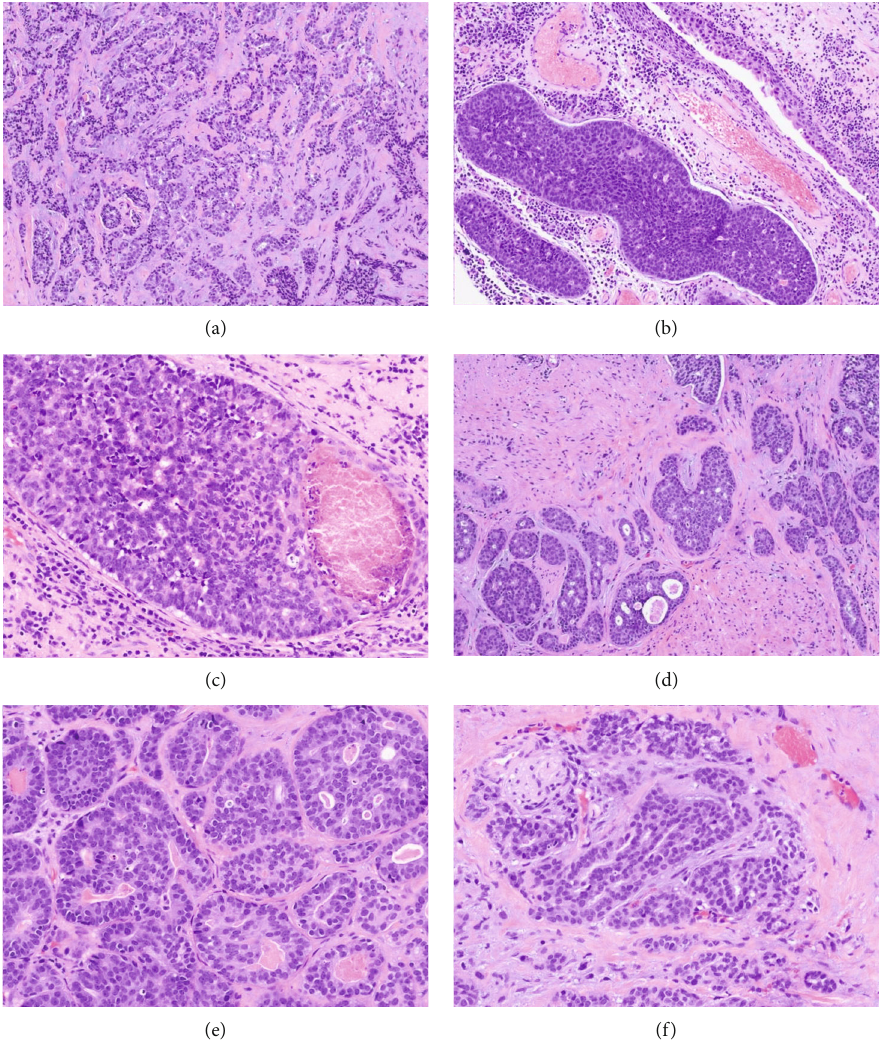
Figure 1: Representative hematoxylin and eosin images (a – f) revealing tumor composed of variably sized irregular solid nests of basaloid cells and anastomosing tubules with desmoplastic stroma (a, 100x magni fi cation). Focal peripheral palisading with peritumoral clefting (b, 100x magni fi cation), comedonecrosis (c, 200x magni fi cation), and invasion into the bladder neck (d, 100x magni fi cation) was noted. Cribriform architecture with eosinophilic hyaline material in the lumen resembling adenoid cystic carcinoma (e, 200x magni fi cation) and perineural invasion (f, 200x magni fi cation) were also